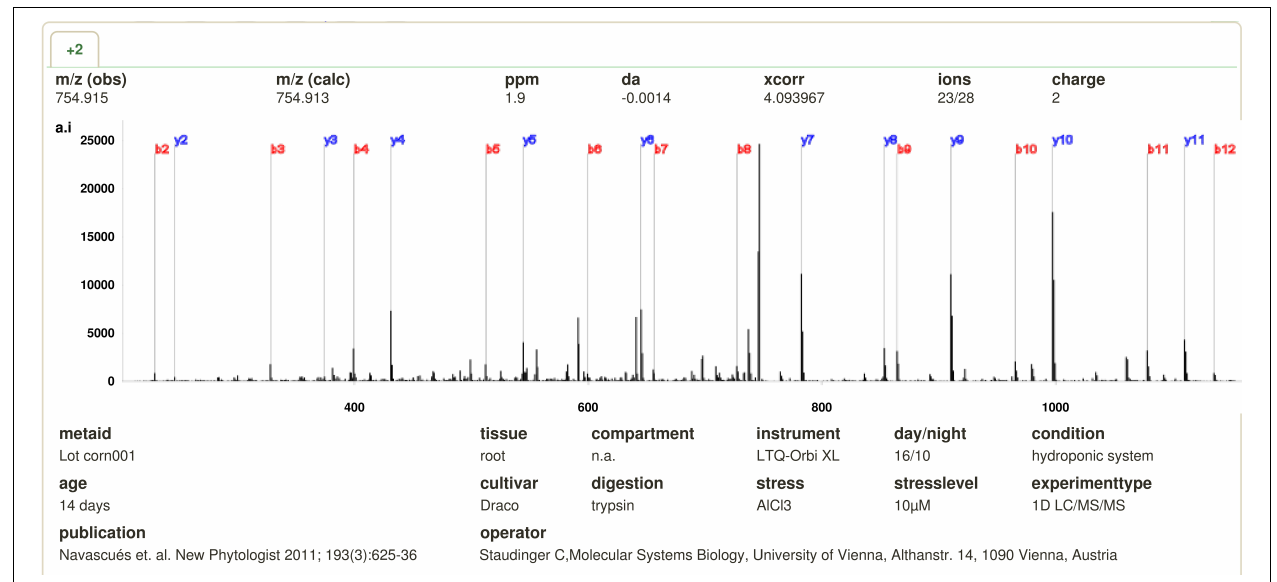
FIGURE 1 | MS/MS spectrum of peptide DLVALSGAHTIGQAR with precursor mass at 754.915. The dominant fragments ions (b, y) are labeled.The experimental conditions are shown below the